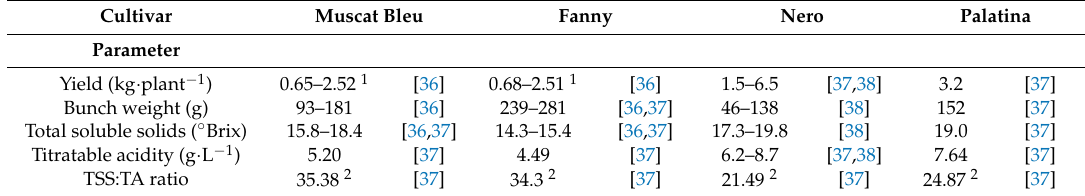
Table 7. Yield and maturity characteristics of field grown table grape cultivars ‘Muscat Bleu’, ‘Fanny’, ‘Nero’ and ‘Fanny’ based on